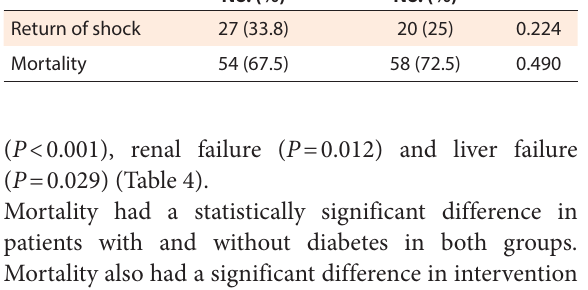
Table 3. Mortality according to underline disease in intervention group and control group